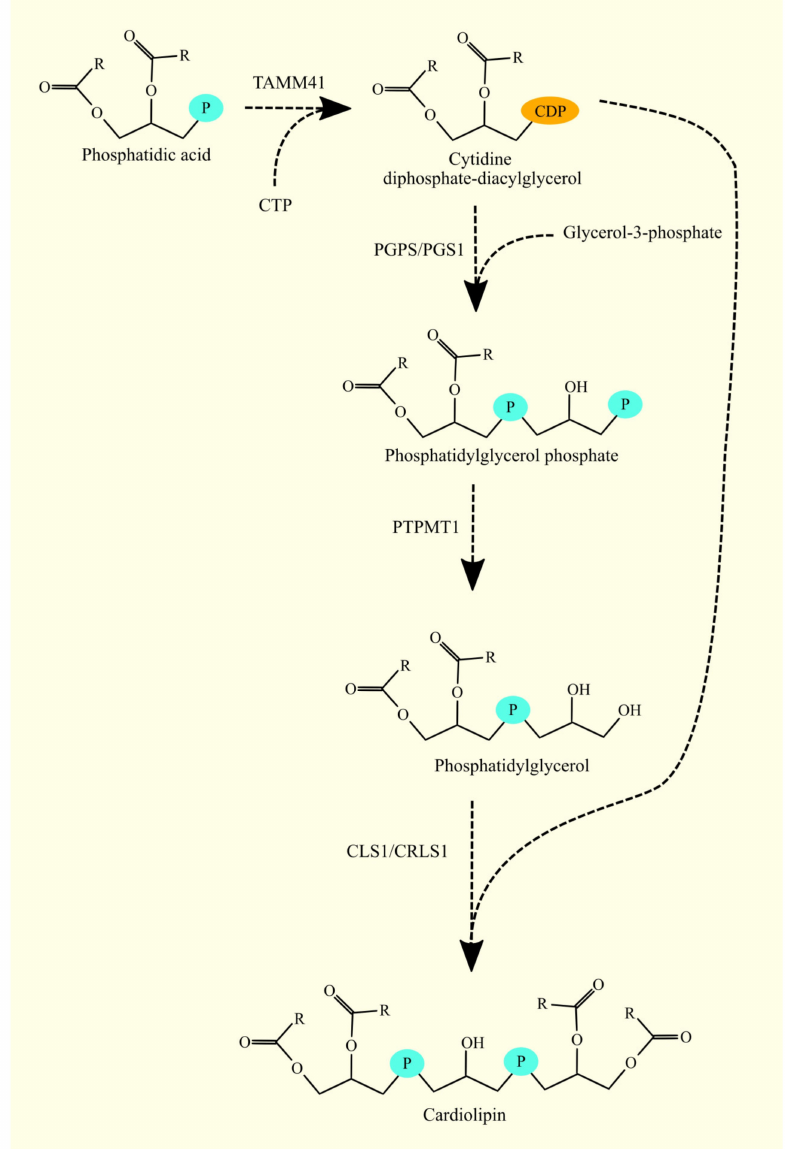
Figure 10. Synthesis of CL. Phosphatidic acid is converted to CDP-DAG. In mitochondria, this reaction is catalyzed by TAMM41. In mitochondria, PG and CL are produced from CDP-DAG. In the first step, PGP is produced from CDP-DAG and glycerol-3-phosphate by PGPS/PGS1. The phosphate group is then removed from this compound by PTPMT1, producing PG. CL is then synthesized from PG and CDP-DAG with the participation of